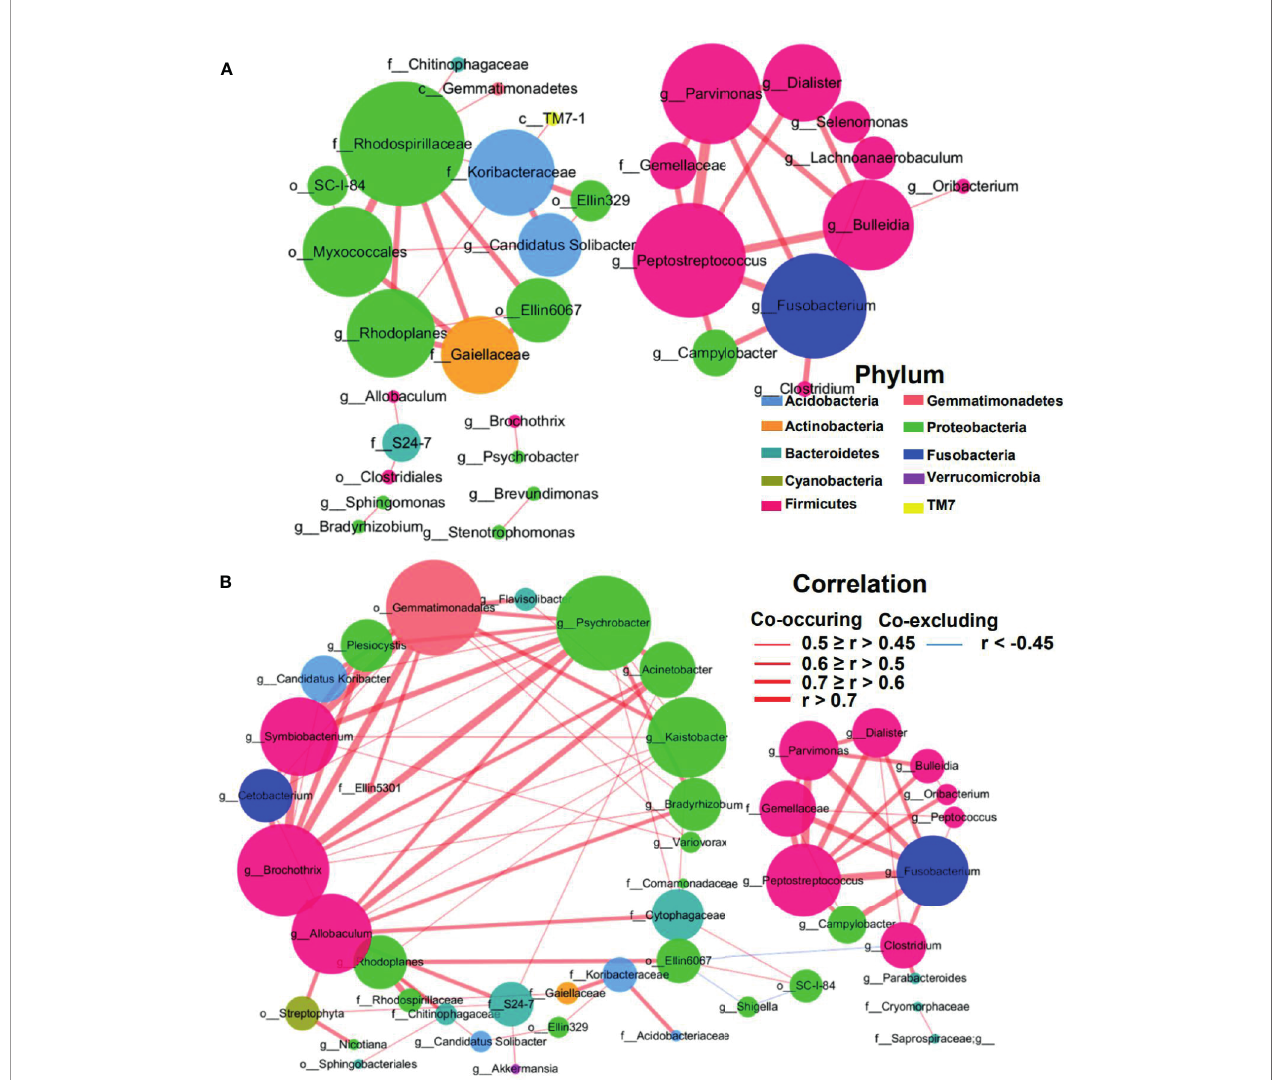
FIGURE 6 | Correlation network of differential MAM in tumor (A) and adjacent normal mucosae (B) . The correlation coef fi cients were calculated with the Sparse Correlations for Compositional data algorithm (SparCC). A subset of signi fi cant correlations with strengths of at least 0.45 in the mucosae commensals at the genera level were selected for visualization using Cytoscape version 3.6. The size of the nodes corresponds to weighted node connectivity (WNC) scores. Red and green lines represent positive and negative correlations,